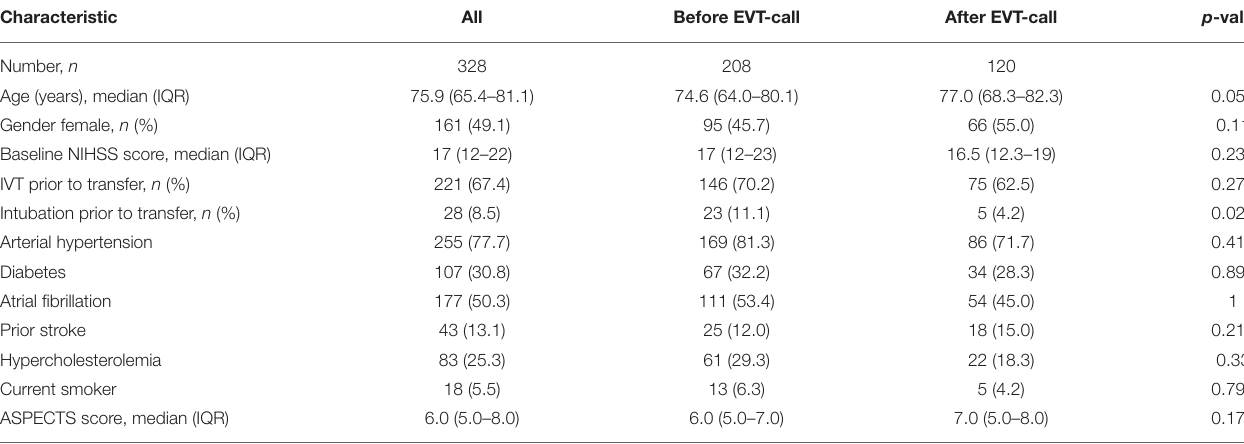
TABLE 1 | Clinical and imaging baseline characteristics of patients according to implementation of the EVT-call; ASPECTS indicates Alberta stroke programme early CT score; IQR, interquartile range; IVT, intravenous therapy; NIHSS, National Institute of Health Stroke Scale. Characteristic